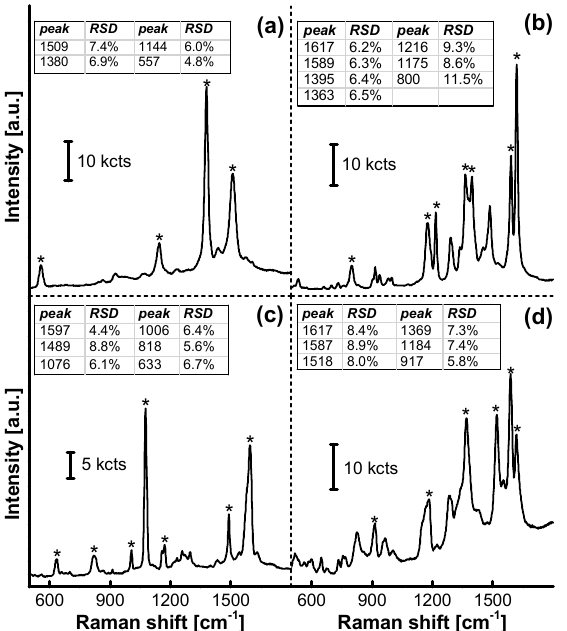
Figure 11. SERRS spectra from a set of analytes on AgNPs/MF 6 . ( a ) Tetramethylthiuram disulfide (LDL: 1.0 × 10 − 8 M. CAS: 137-26-8; disinfectant, mildew preventive, pesticide, residue over seven days and vulcanization accelerator in rubbers); ( b ) malachite green (LDL: 1.0 × 10 − 7 M. CAS: 2437- 29-8; dye and toxic antiseptic for aquaculture); ( c ) p-hydroxythiophenol (LDL: 1.0 × 10 − 7 M. CAS: 637-89-8; pharmaceutical and dye intermediate); ( d ) basic violet 14 (LDL: 1.0 × 10 − 9 M. CAS: 632- 99-5; dye). Each concentration of the analytes was 1.00 × 10 − 5 M, the MF 6 in SERRS substrate was synthesized at n = 6.00, pH = 4.0, and at a temperature of 65 ◦ C for 20 min and acid-treated at a pH of 4.00 and at a temperature of 40 ◦ C for 10 min. The position of the Raman peak of each material is marked with “*”. The detection limits for each analyte are shown in Supplementary Materials Figures